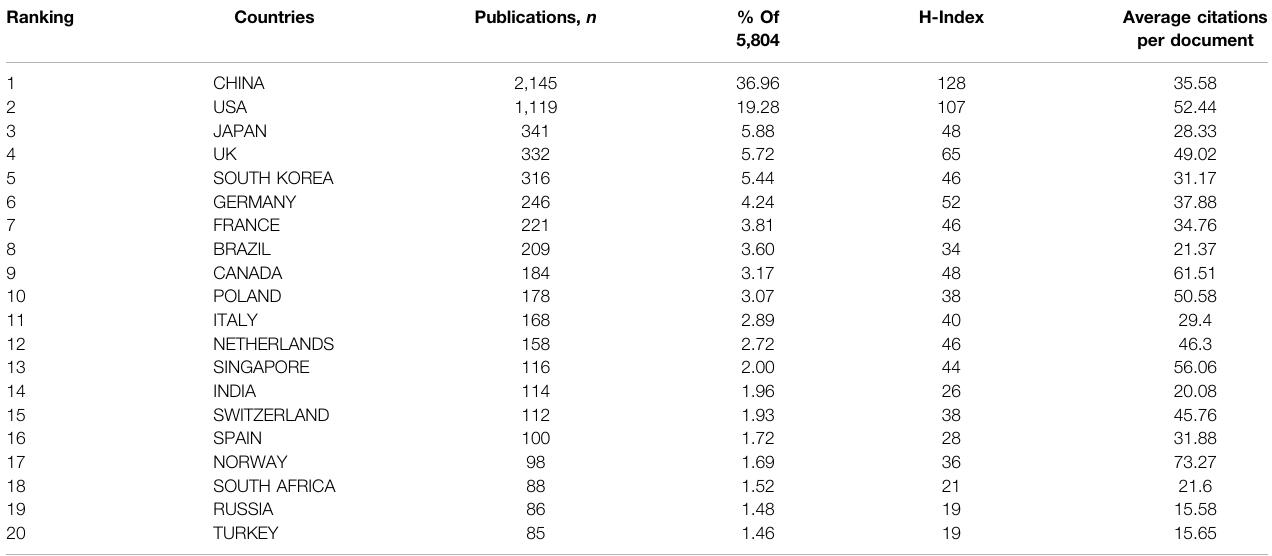
TABLE 1 | Top 20 productive countries/regions related to CPDT.